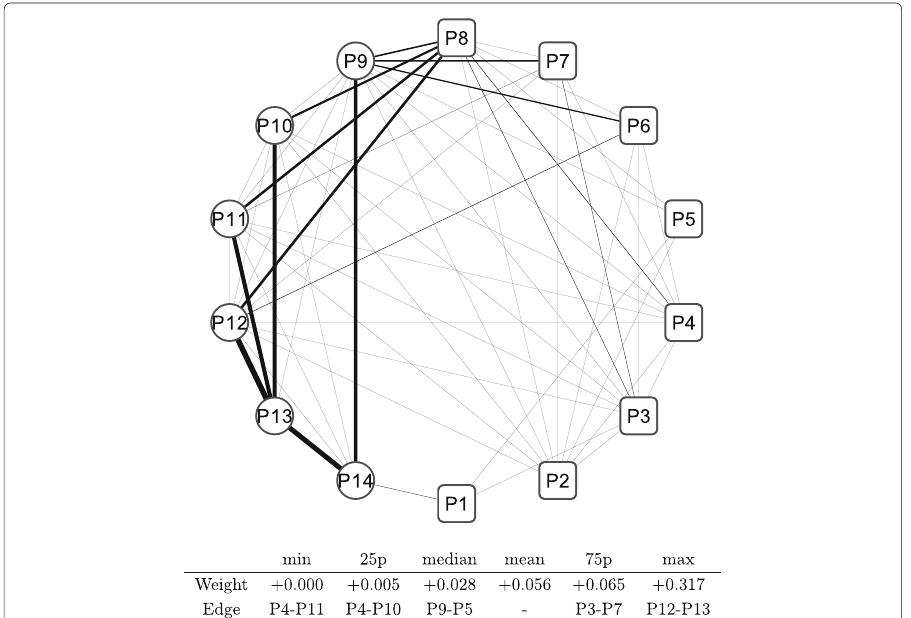
Fig. 12 Changes in network between sub-periods: T1–T2. Note: The network shows the difference between the sub-period T1 and T2. The edge weight (the edge width) is calculated by subtracting elements of the adjacency matrix of T2 from those of T1 described as T1 − T2. Only the edges that have positive weights (T1 > T2) are shown. The bottom table shows the quantiles of edge weights distribution with corresponding edges